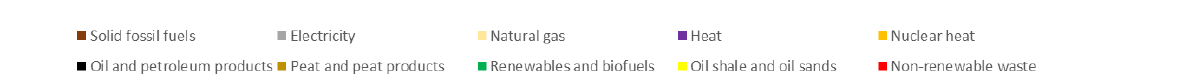
Figure 1. Primary energy production by fuel [TJ]. Source: Own elaboration based on Eurostat data [19].